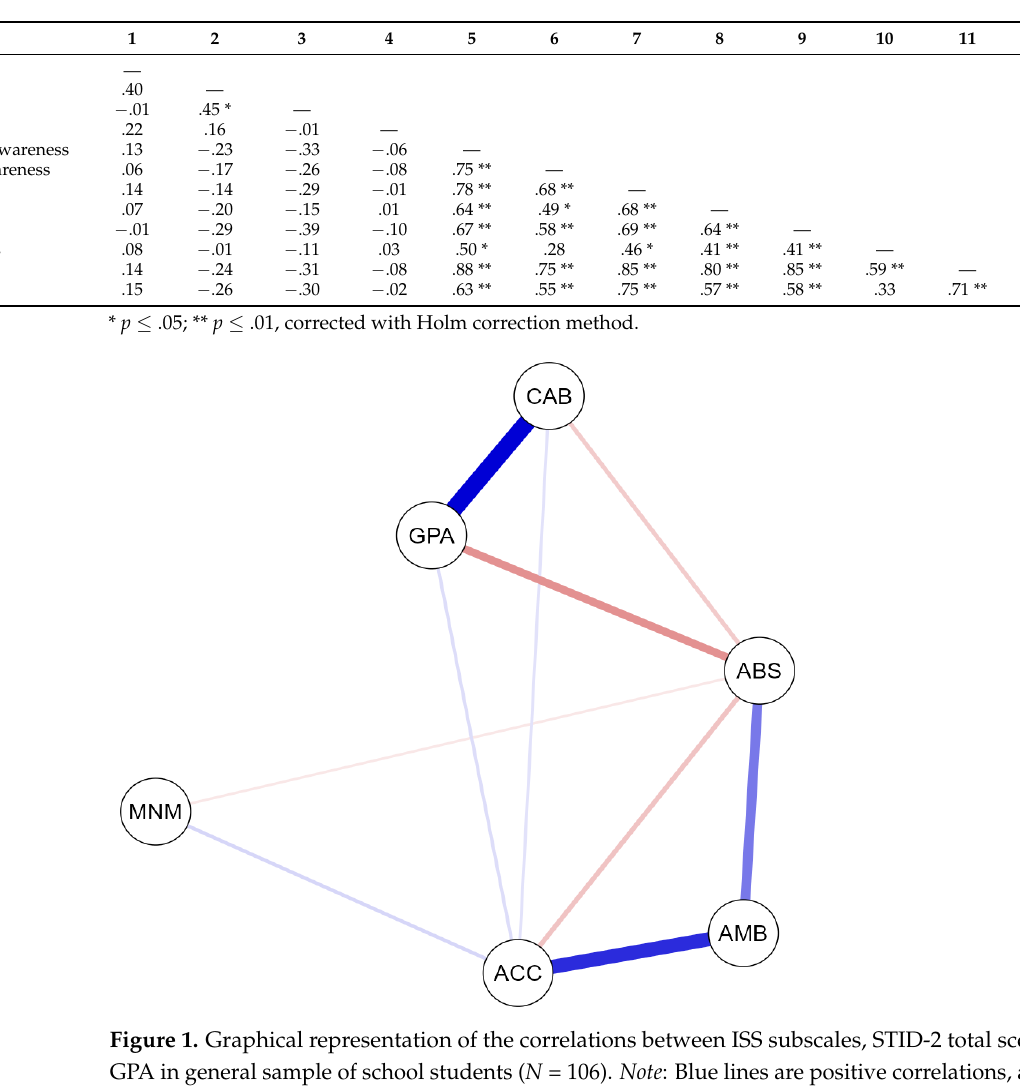
Table 4. Spearman’s correlations between all studied variables in sample of female students ( N = 55).